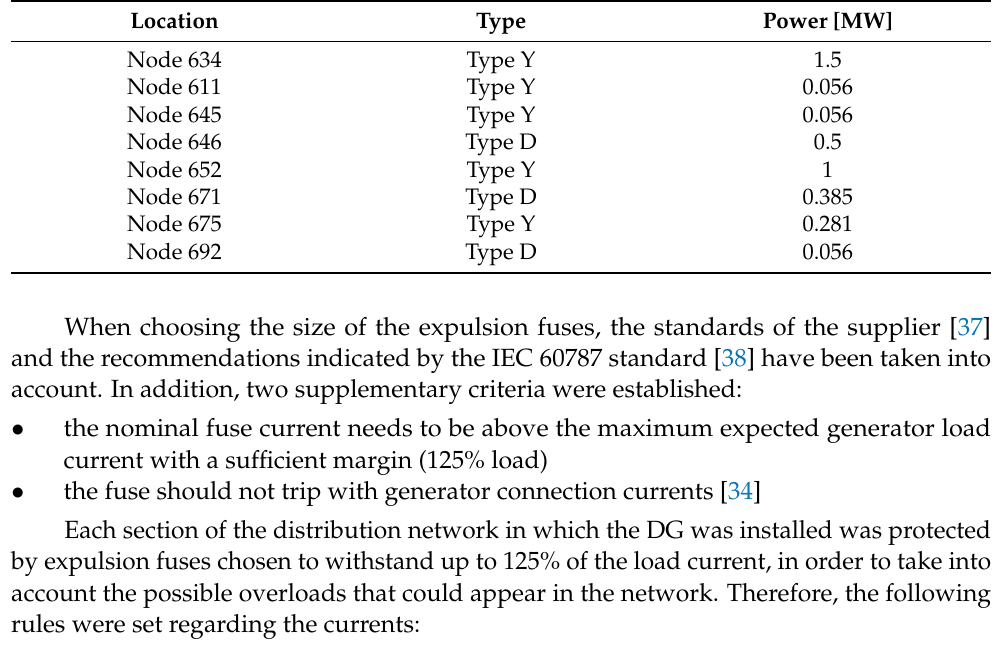
Table 3. Loads considered in the analyzed